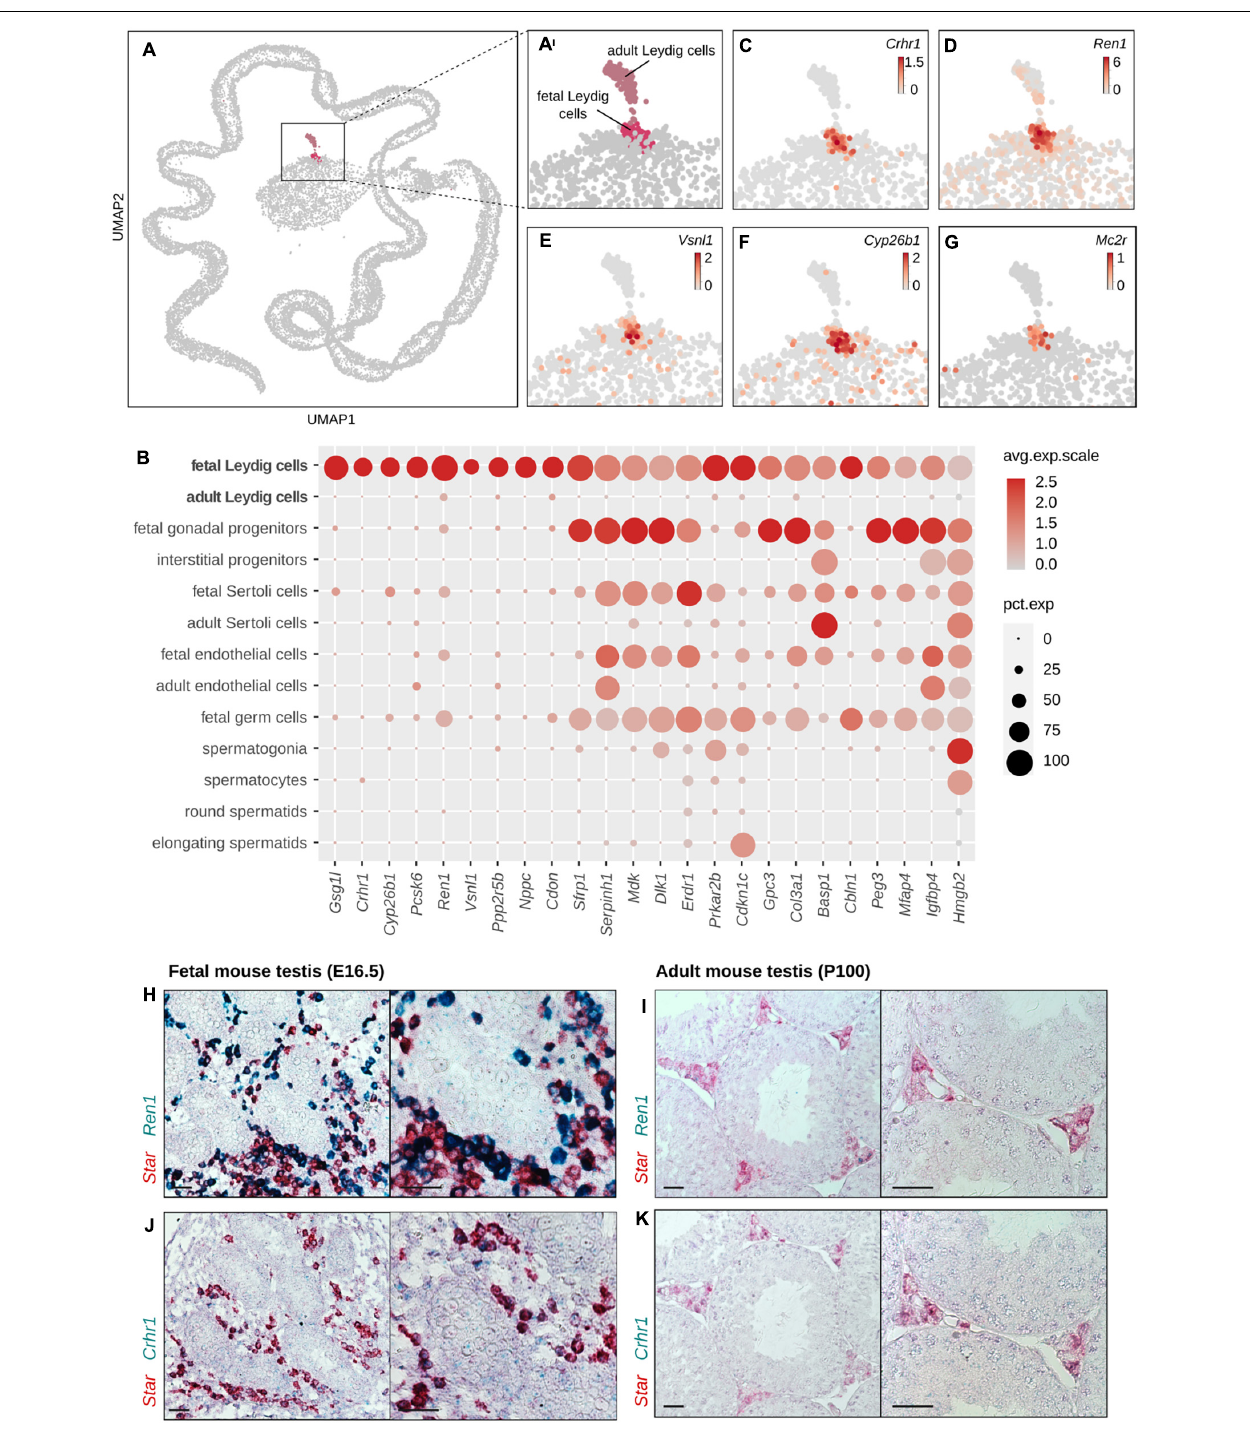
FIGURE 4 | Identification of genes labeling FLCs. (A,A (cid:48) ) UMAP representation of single-cell transcriptomes highlighting the two Leydig cell populations: fetal Leydig cells (FLCs) in pink and adult Leydig cells (ALCs) in gray pink. The other populations of the testis are colored in gray. (C–G) Enlargement on the UMAP representation colored according to the normalized expression of selected FLC-specific candidate marker genes, like Crhr1 (C) , Ren1 (D) , Vsnl1 (E) , Cyp26b1 (F) , and Mc2r (G) . (B) Dotplot displaying the scaled expression of the FLC-specific candidate genes, and the top 15 non-specific candidates discriminating FLCs over ALCs. (H–K) In situ hybridization assay by RNAscope labeling in red Star , a known marker of Leydig cells, and in green the FLC marker Ren1 (H,I) and Crhr1 (J,K) in embryonic mouse testis at E18.5 (H,J) and in adult mouse testis at P100 (I,K) . The colocalisation of the red and green probes indicate a co-expression of the two genes in the Leydig cells. The black scale bar corresponds to 100 µ